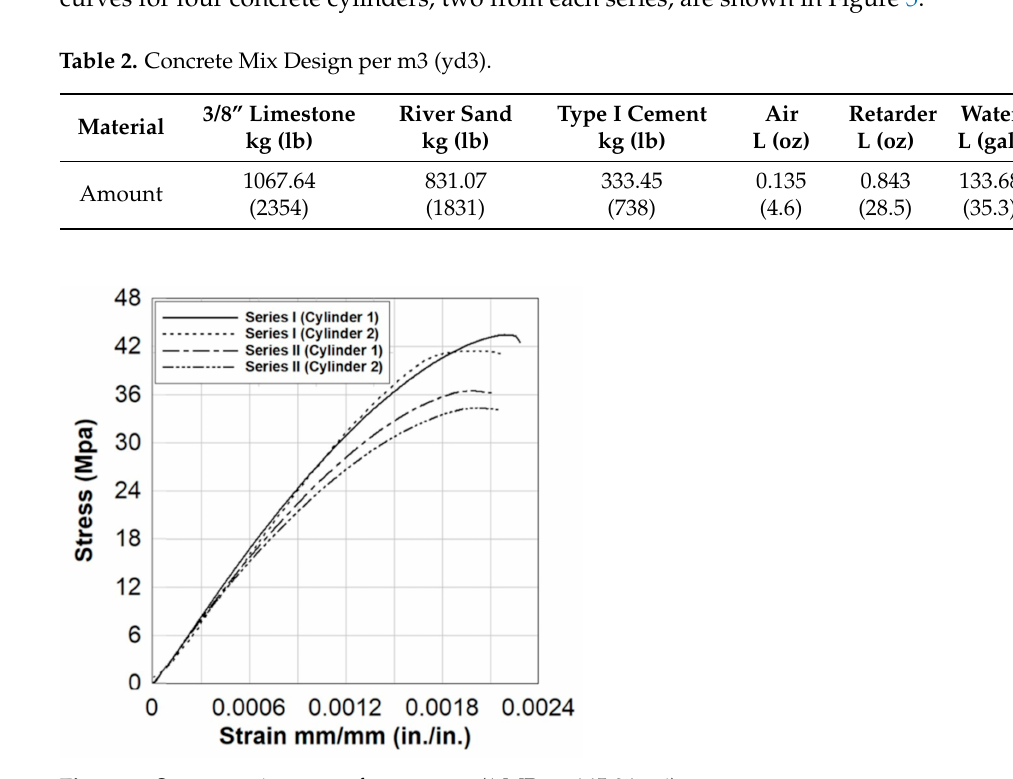
Figure 5. Stress–strain curves for concrete (1 MPa = 145.04 psi).